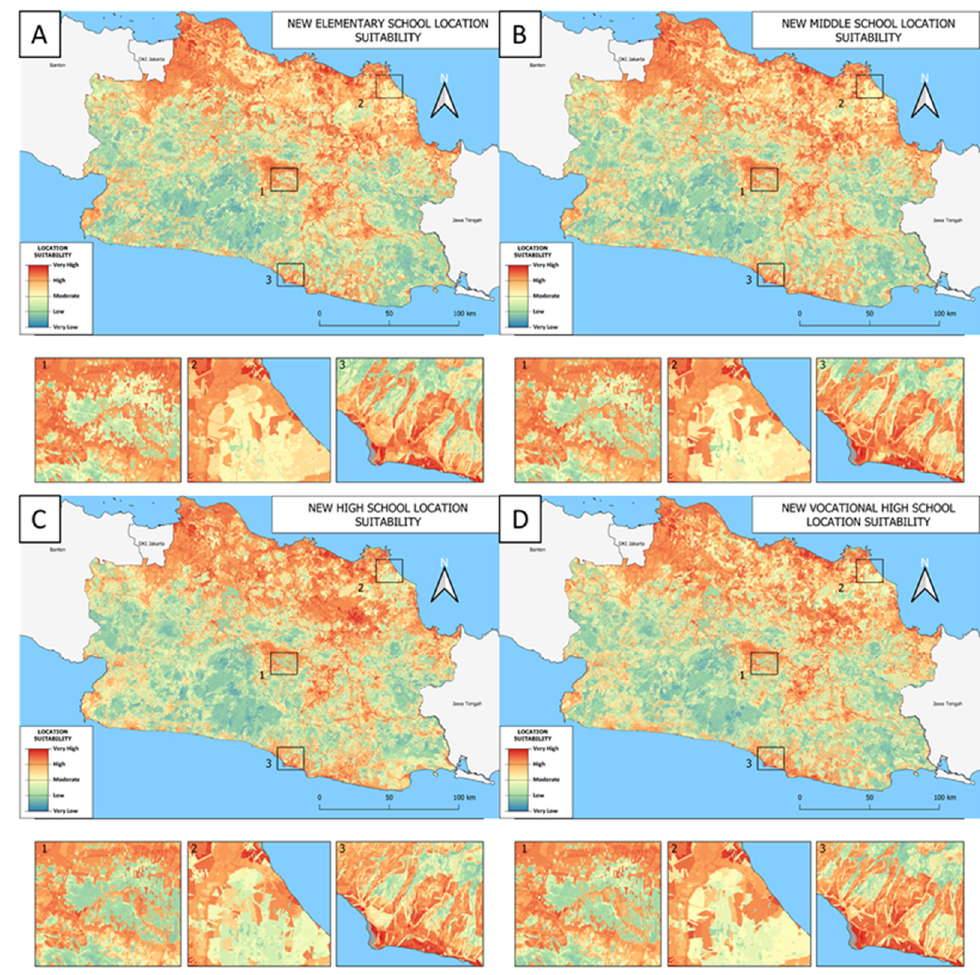
Figure 11. New school land suitability distribution for: ( A ) elementary, ( B ) junior high, ( C ) senior high, and ( D ) vocational high schools.